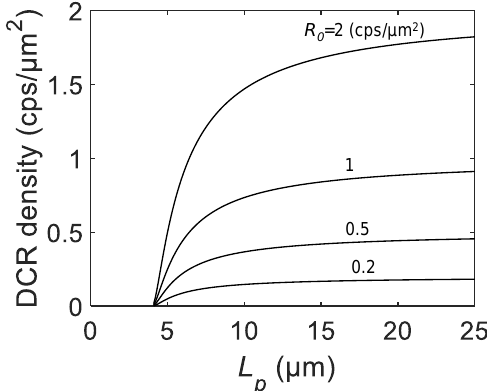
Figure 6. The calculated DCR density as a function of the SPAD pixel pitch L p for R 0 = 0.2, 0.5, 1, and 2 cps/ µ m 2 , active-to-active distance L a − a = 3 µ m, and inactive radius r in = 0.5 µ